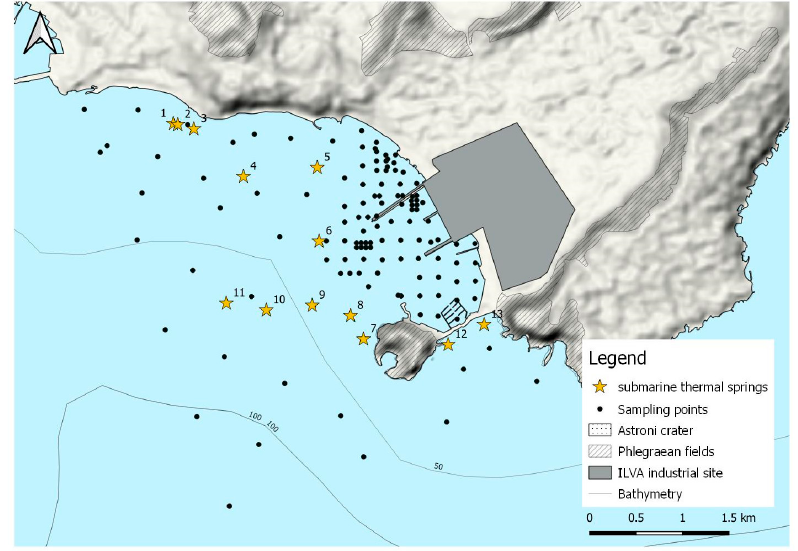
Figure 4. Location of natural sources inside the Bagnoli bay [12,18].